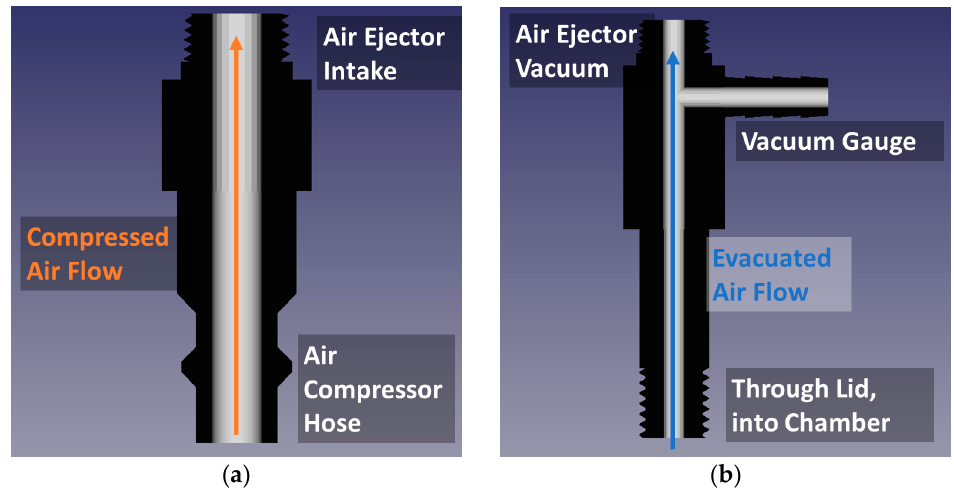
Figure 2. Air ejector connector cross-sections, highlighting internal geometry where air flows. ( a ) Intake connector, where high pressure air enters the ejector; ( b ) vacuum connector, where evacuated air flows from the chamber to the ejector and vacuum pressure is measured.